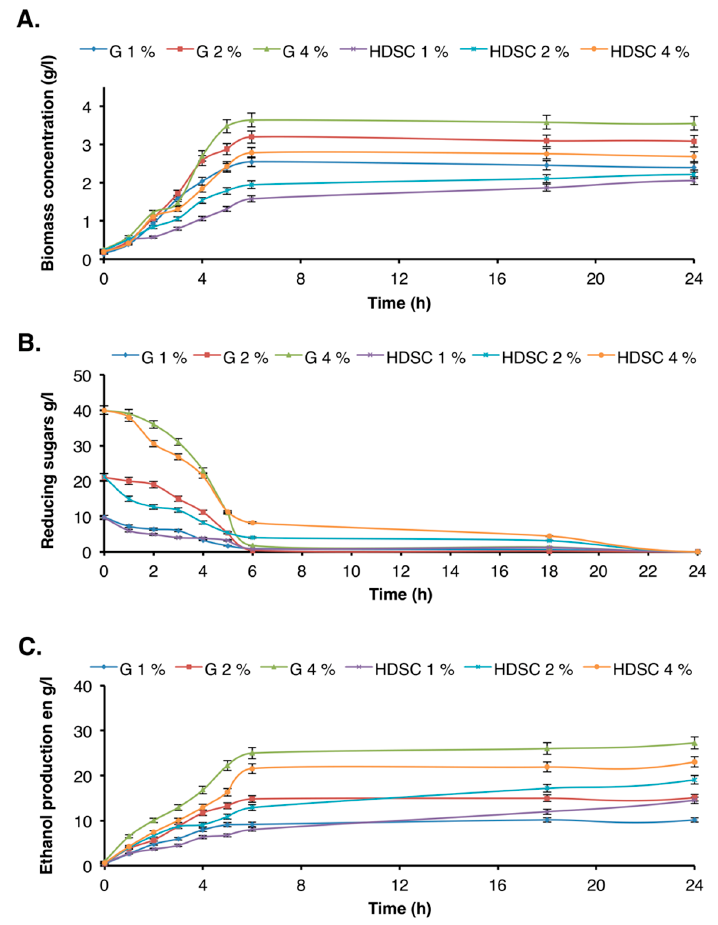
Figure 6. Determination of fermentation parameters: ( A ) biomass concentration, ( B ) reducing sugars, ( C ) bioethanol production. G 1%, G 2%, and G 4% represent respectively the concentrations of commercial glucose used as control for ethanol production. HDSC denotes hydrolyzate of date seed cellulose.